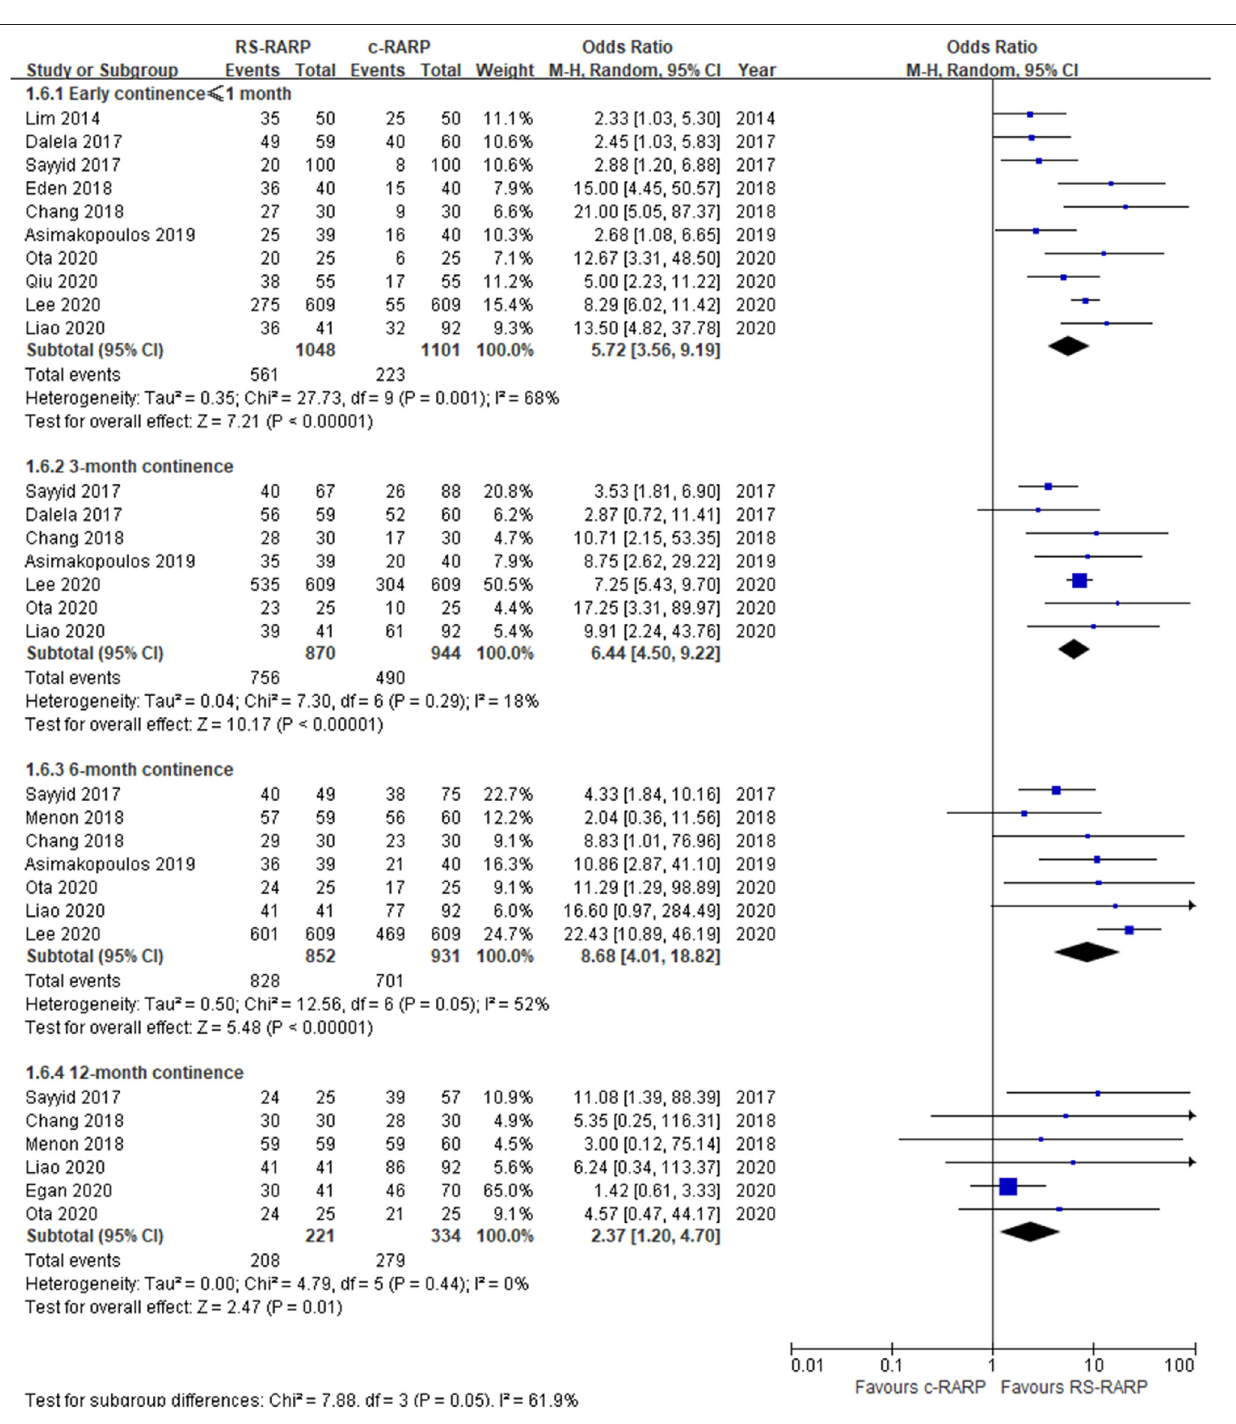
FIGURE 7 | Forest plot of postoperative